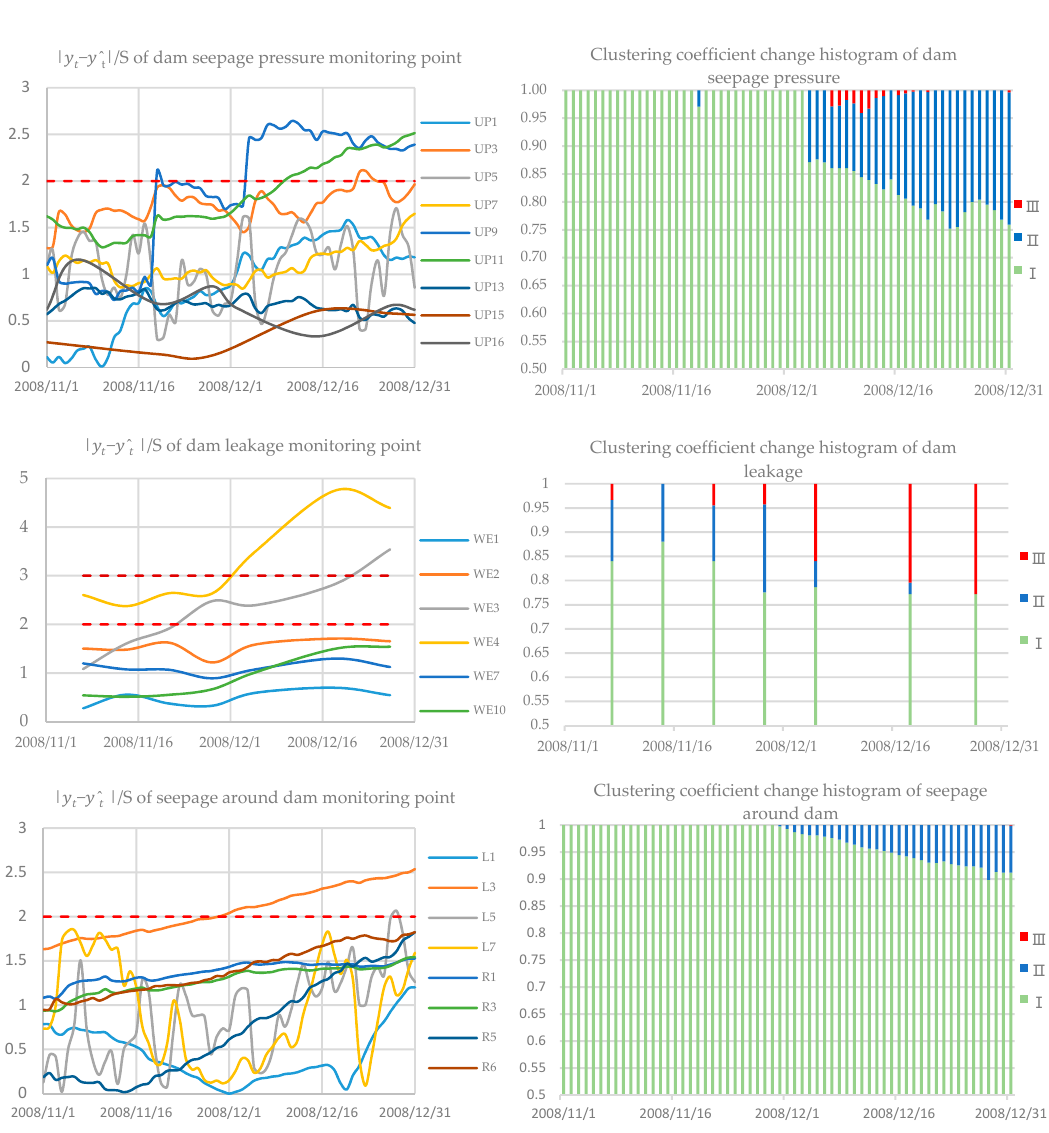
Figure 8. Schematic diagram of the definite weighted function.